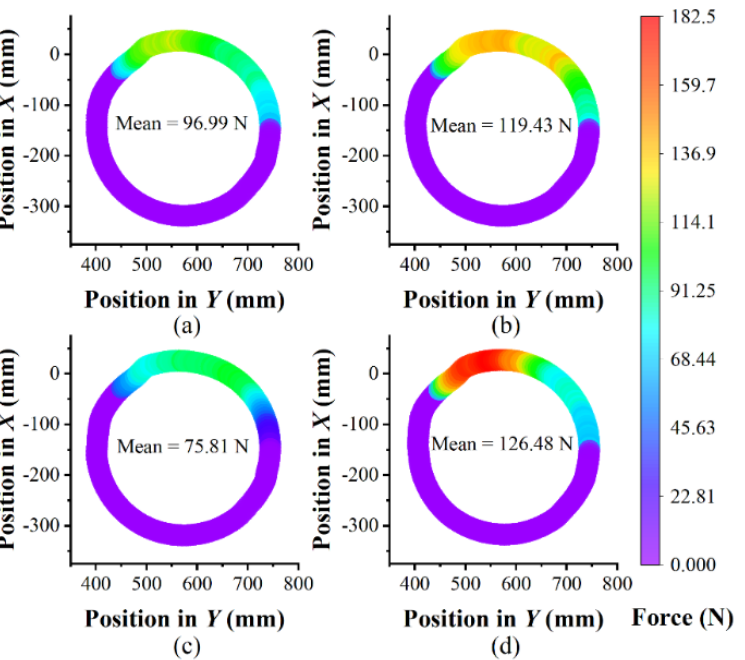
Figure 5. Color mapped of effective interaction forces from user’s right leg in different event feedbacks along the trajectory: ( a ) general, ( b ) muddy, ( c ) downhill and ( d ) uphill. The start position is the leftmost point on the trajectory in Y axis direction, and the moving direction is clockwise during the training. Average force is just calculated from AZ (the zone except purple). The X and Y coordinates are same as Figure 2.